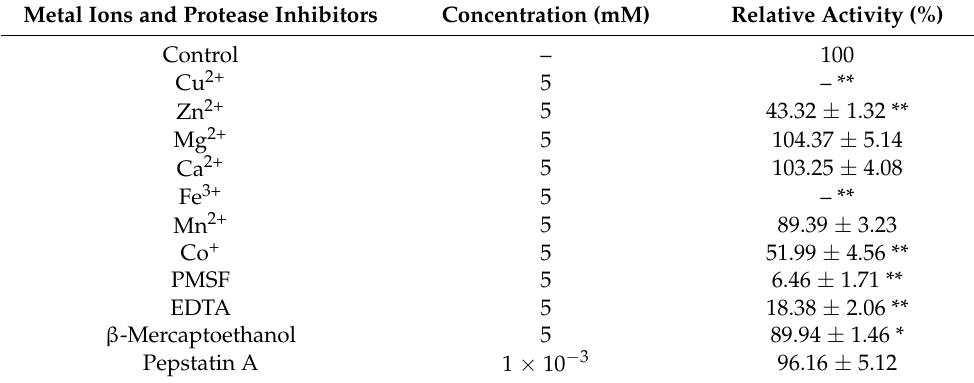
Table 2. Effect of metal ions and protease inhibitors on the activity of Velefibrinase. Metal Ions and Protease Inhibitors